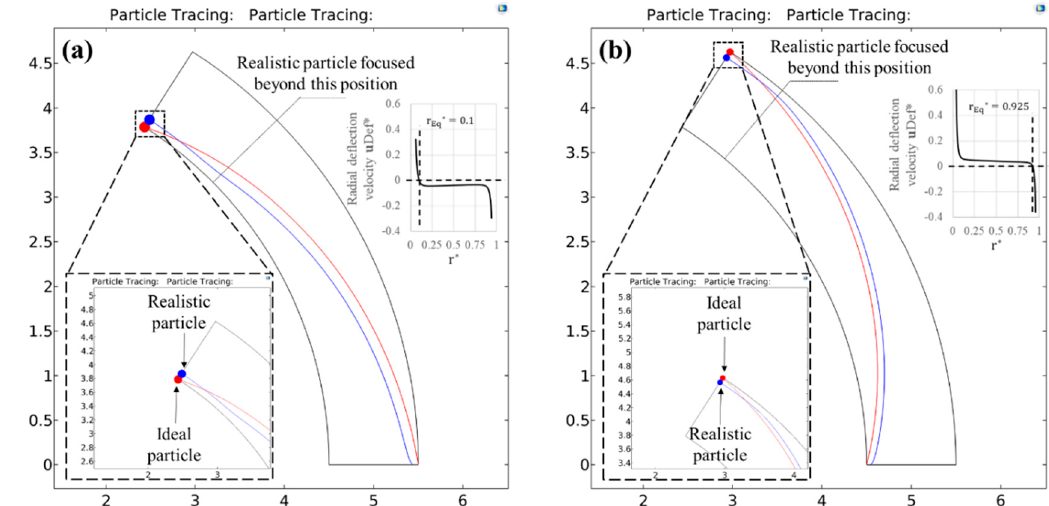
Figure 5. Numerically predicted path-lines for the ideal and realistic test particles under the action of ( a ) positive DEP ( Real ( f CM ) = 0.5) and ( b ) negative DEP ( Real ( f CM ) = − 0.5) inside a circular arc microchannel having a curvature ratio R C ∗ of 5. The dimensionless particle diameter d ∗ is chosen as (cid:12) ∗ (cid:12) (cid:12) (cid:12) 0.12 for positive DEP and its motion is driven by a dimensionless voltage of (cid:12) V App (cid:12) = 694.44 predicted from the exact solution. Similarly, the dimensionless particle diameter d ∗ is chosen as 0.08 for negative (cid:12) ∗ (cid:12) (cid:12) (cid:12) DEP and its motion is driven by a dimensionless voltage of (cid:12) V App (cid:12) = 1562.5 as predicted by the exact solution. These particle sizes demonstrate a regime 3 behaviour, where the realistic particle motion deviate significantly from the ideal behaviour. This is evident from the fact that the realistic particles in both cases of DEP are focused substantially before they reach the microchannel outlet. The location of full focusing along the arc length is highlighted by the dotted lines, where a kink in the particle path-line is visible, and the particle is seen traveling parallel to the channel wall beyond that point. This regime is characterised by more reduced voltage requirements to focus the particles fully due to the assistance of wall repulsion forces. The inset images represent a 1-D radial profile of the net radial particle velocity component, along with the identification of the equilibrium radial